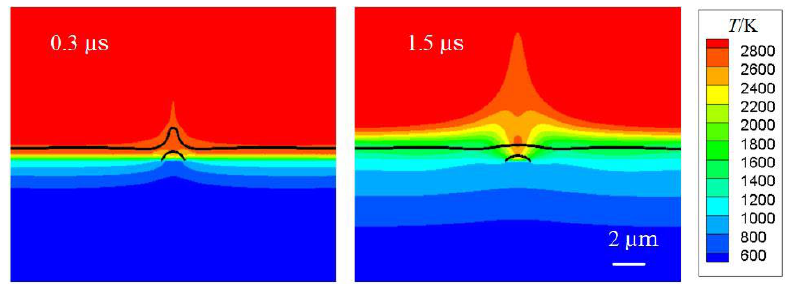
Figure 11. Temperature distribution at particular instants.